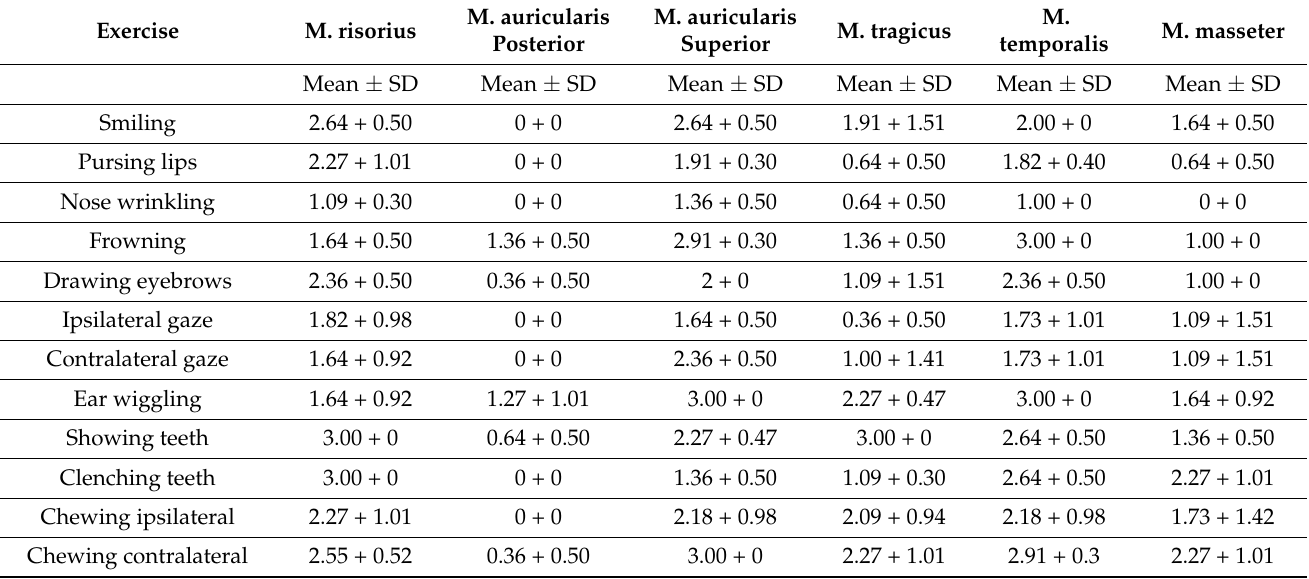
Table 2. Healthy probands: average surface multi-channel EMG activity * synchronously in several ear muscles, chewing muscles and one mimic muscle during different tasks summarized for both sided of the face.